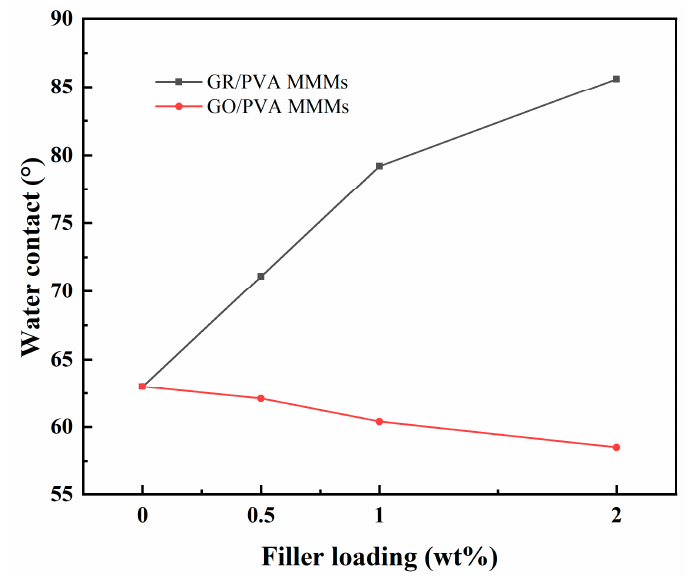
Figure 7. Effect of filler loading on contact angles of GR/PVA and GO/PVA MMMs.